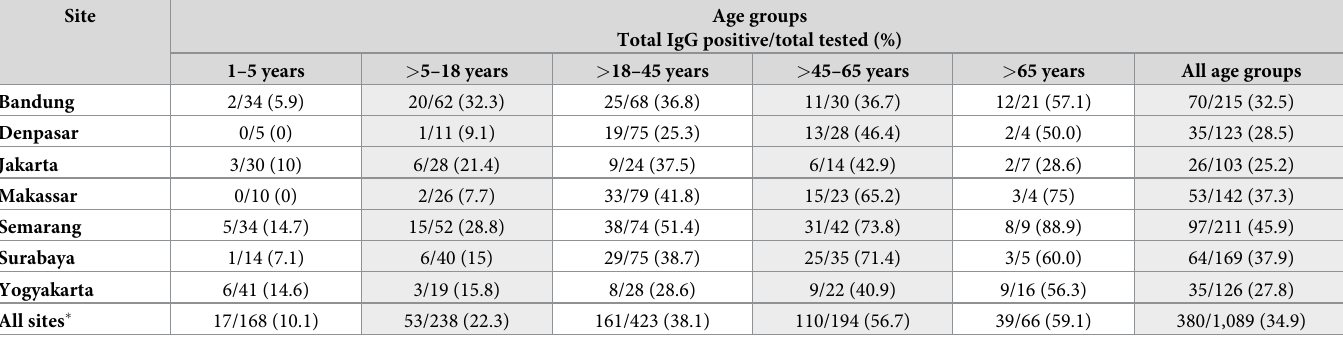
Table 1. Evidence of prior CHIKV exposure based on IgG sero-positivity by site and age.